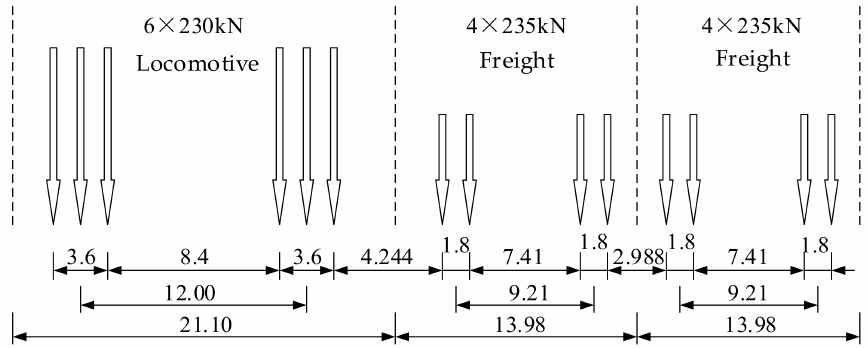
Figure 10. The Wheelbase Distribution of the Locomotive/Freight Car. (Unit: m). In the dynamic tests, the accelerations of the bridge deck were recorded under am- bient excitation. In total, the accelerations at 65 measuring points were recorded. The sampling frequency and sampling time for each setup were 200 Hz and 15 min, respectively.